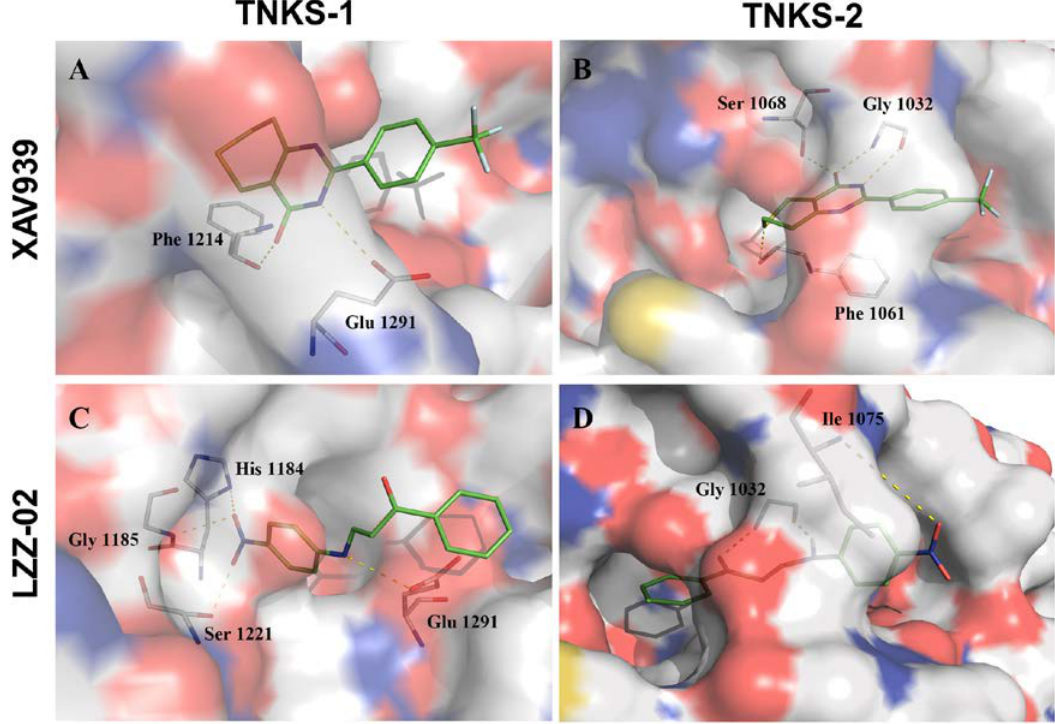
Figure 7. Binding mode of compounds XAV939, LZZ-02 in the active site of TNKS-1 (PDB: 2RF5) ( A , C ) and TNKS-2 (PDB: 3KR8) ( B , D ). Hydrogen bond was represented with yellow dashed line. All graphical picture was generated using PyMol program (http://www.pymol.org/).